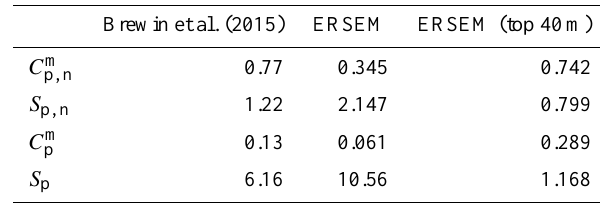
Table 1. Parameters of the fits to the three-population absorption model for the Brewin et al. (2015), and for ERSEM. Two fits to ERSEM are shown: the first is the fit to the ERSEM data set ex- cluding the polar, shallow and inland seas, and the second includes all these regions to a depth of 40m. The parameters are C m p, n : max- imum piconano chlorophyll, S p, n is the slope for piconano chloro- phyll, C m p is the maximum picophytoplankton chlorophyll and S p is the slope for picophytoplankton.